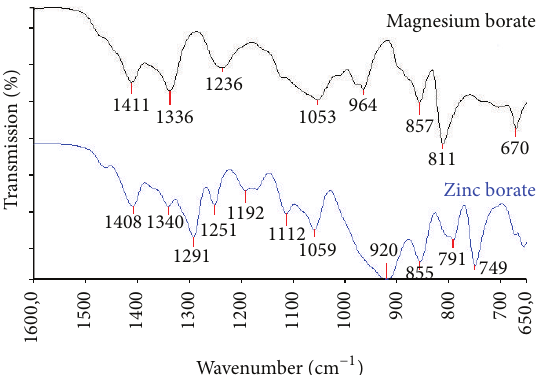
Figure 5: Raman patterns of the optimum phases of the magnesium and zinc